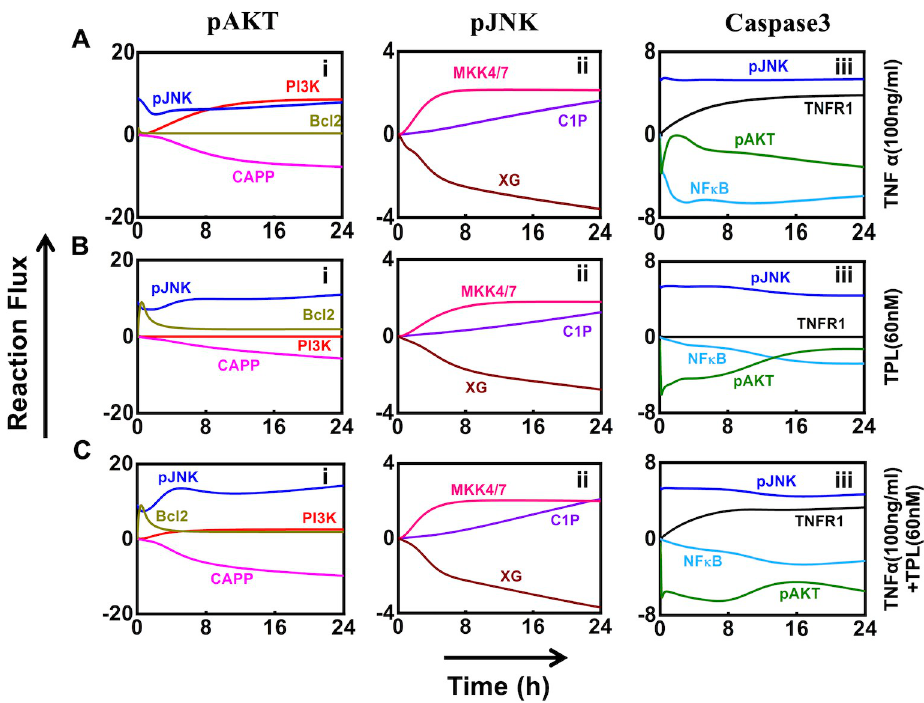
Fig 3. The evolution of majorly contributing fluxes towards pAKT, pJNK and Caspase3. Panels (A), (B), and (C), respectively show the evolution of fluxes for the three markers under the stimulation conditions TNF α , TPL, and TNF α + TPL. In each of the panels (i), (ii), and (iii), respectively show the evolution of fluxes contributing to dynamics of pAKT, pJNK and Caspase3 dynamics for the three different stimulation conditions. The individual reaction fluxes were estimated using the rate equation described in S4 Table. Evolution of all contributing fluxes has been presented in S10